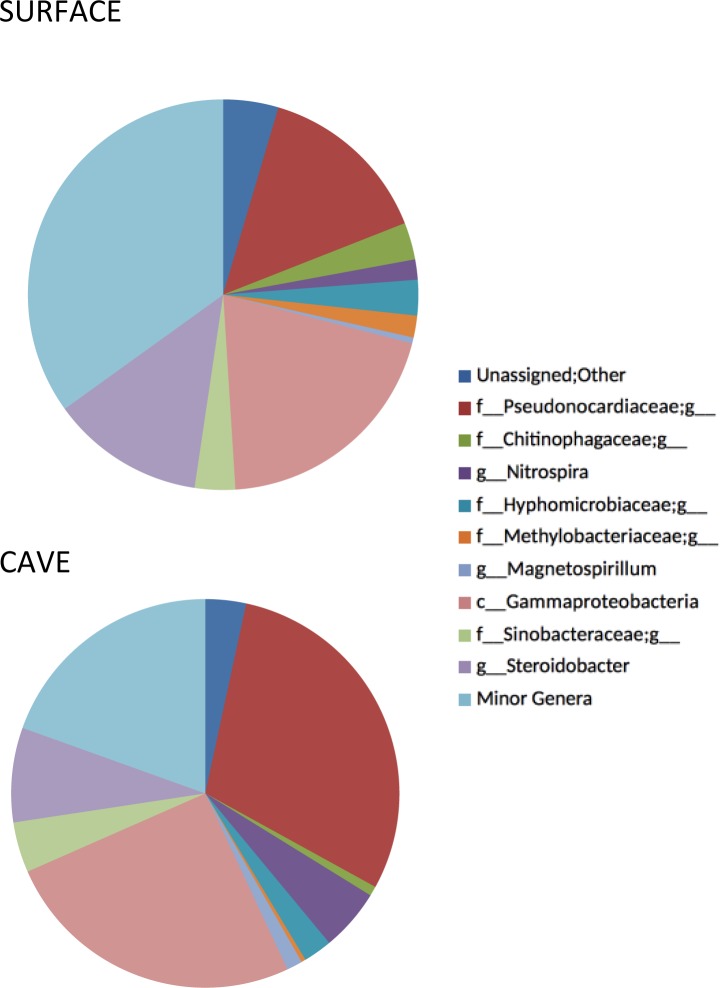
Percent OTUs by lowest level of classification (family or genus).(A) mean surface soils and (B)mean cave microbial mats.